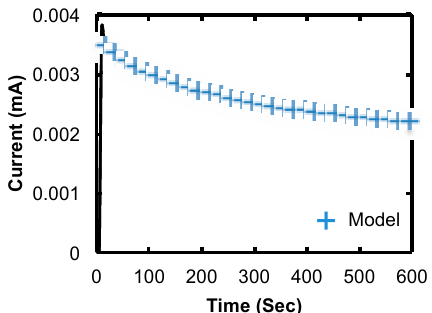
Figure 11. Plot of current vs. time during EPD for short SWCNTs from a dense linear array of windows.